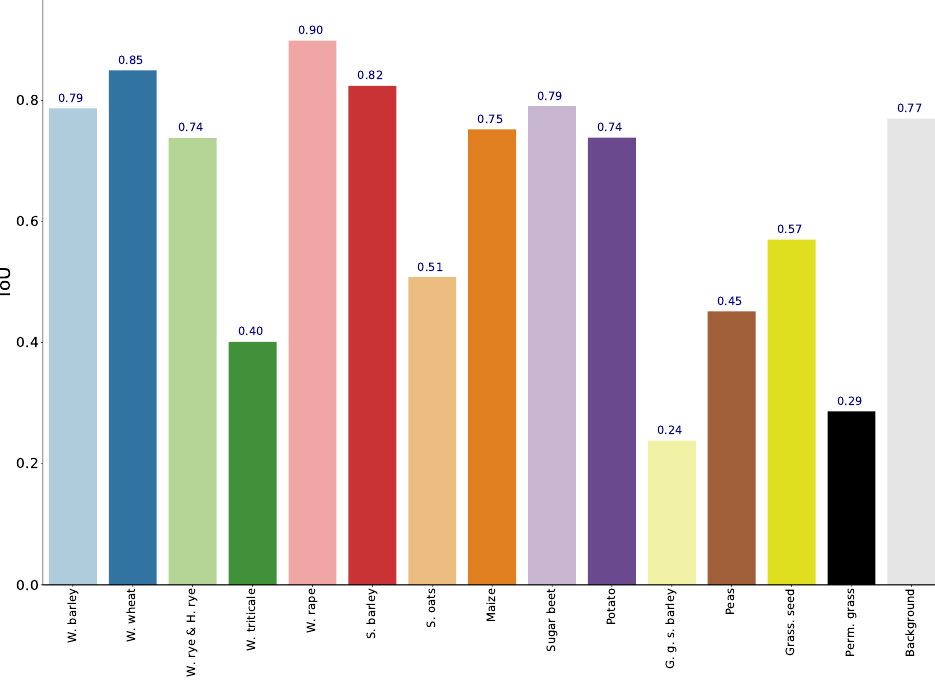
Figure 10. The IoU of all analyzed crops by the end of